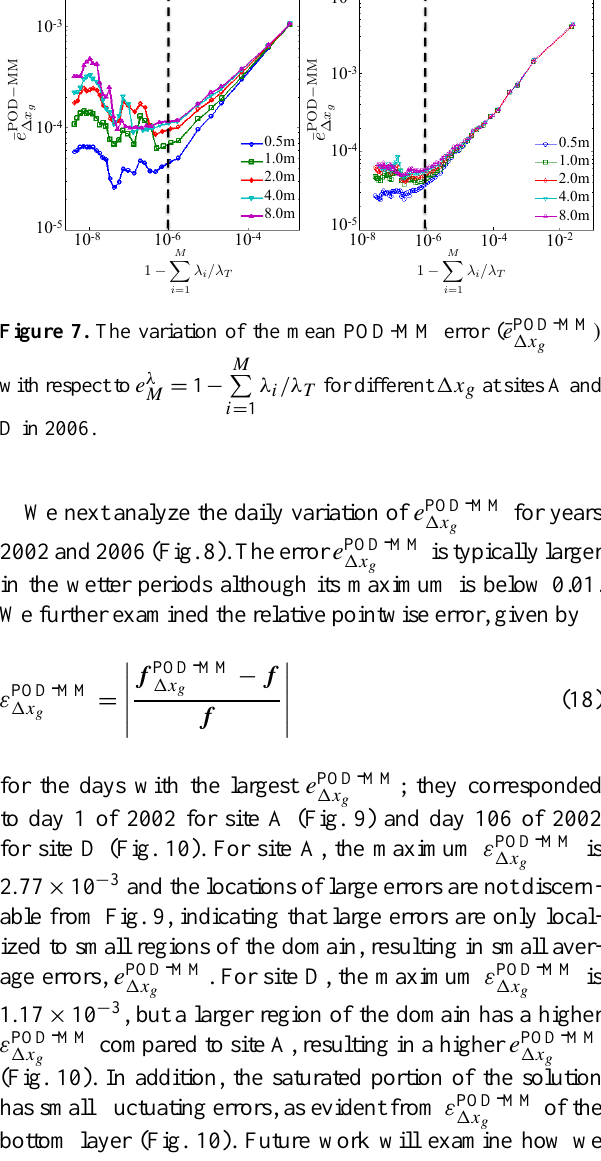
Figure 4. Relation between mean soil moisture µ f ( q ) = µ θ ( q ) and ( q ) for sites A, B, C, and D. The lines are linear fits to the data α POD 1 (symbols).